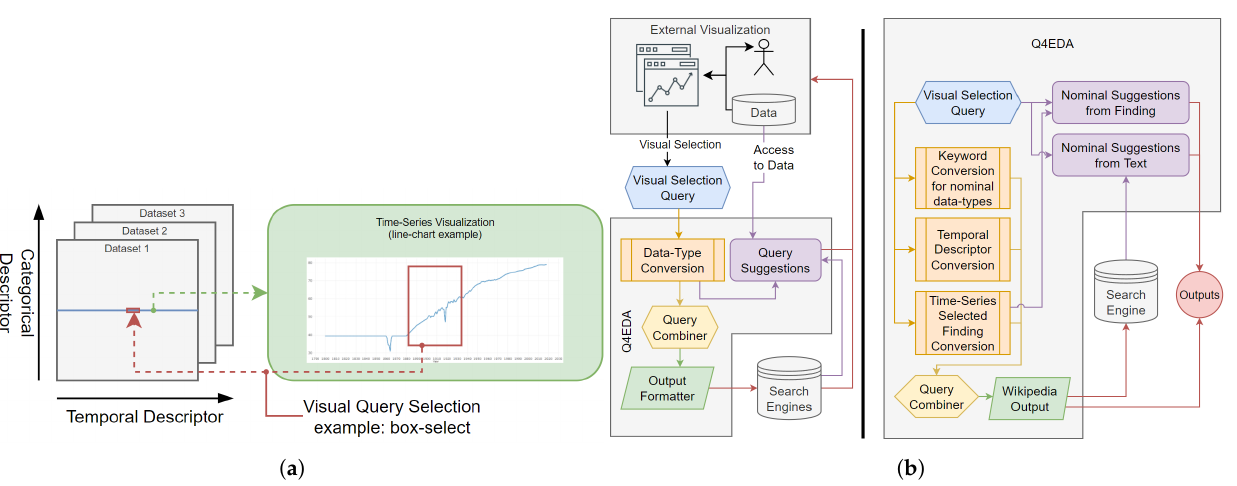
Figure 1. Overall summary of Q4EDA. ( a ) Time-series dataset collection structure expected by Q4EDA (left) is composed of multiple time-series datasets. Each row of the many datasets are the time-series which are visualized through tools such as Gapminder [59], and a selection within such visualization (in red) comprises the Visual Selection Query (VQ) converted by Q4EDA. ( b ) Overview of Q4EDA conversion and suggestion processes. Q4EDA expects to have access to a dataset collection and a given user’s VQ (left), and the inner operations convert each data-type into output queries which are combined as a valid SQ (right). After executing the SQ in a SE and retrieving the text documents, Q4EDA also provides query